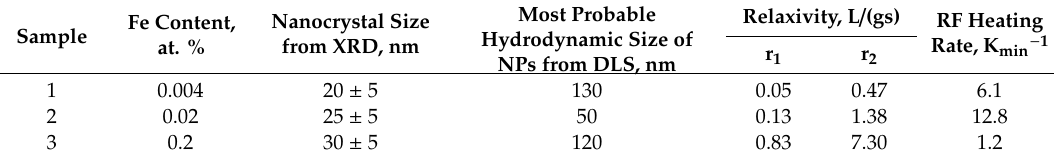
Table 2. Characteristics of Si NPs with iron impurities. (Reprinted from Reference [101] by permission from John Wiley and Sons ©